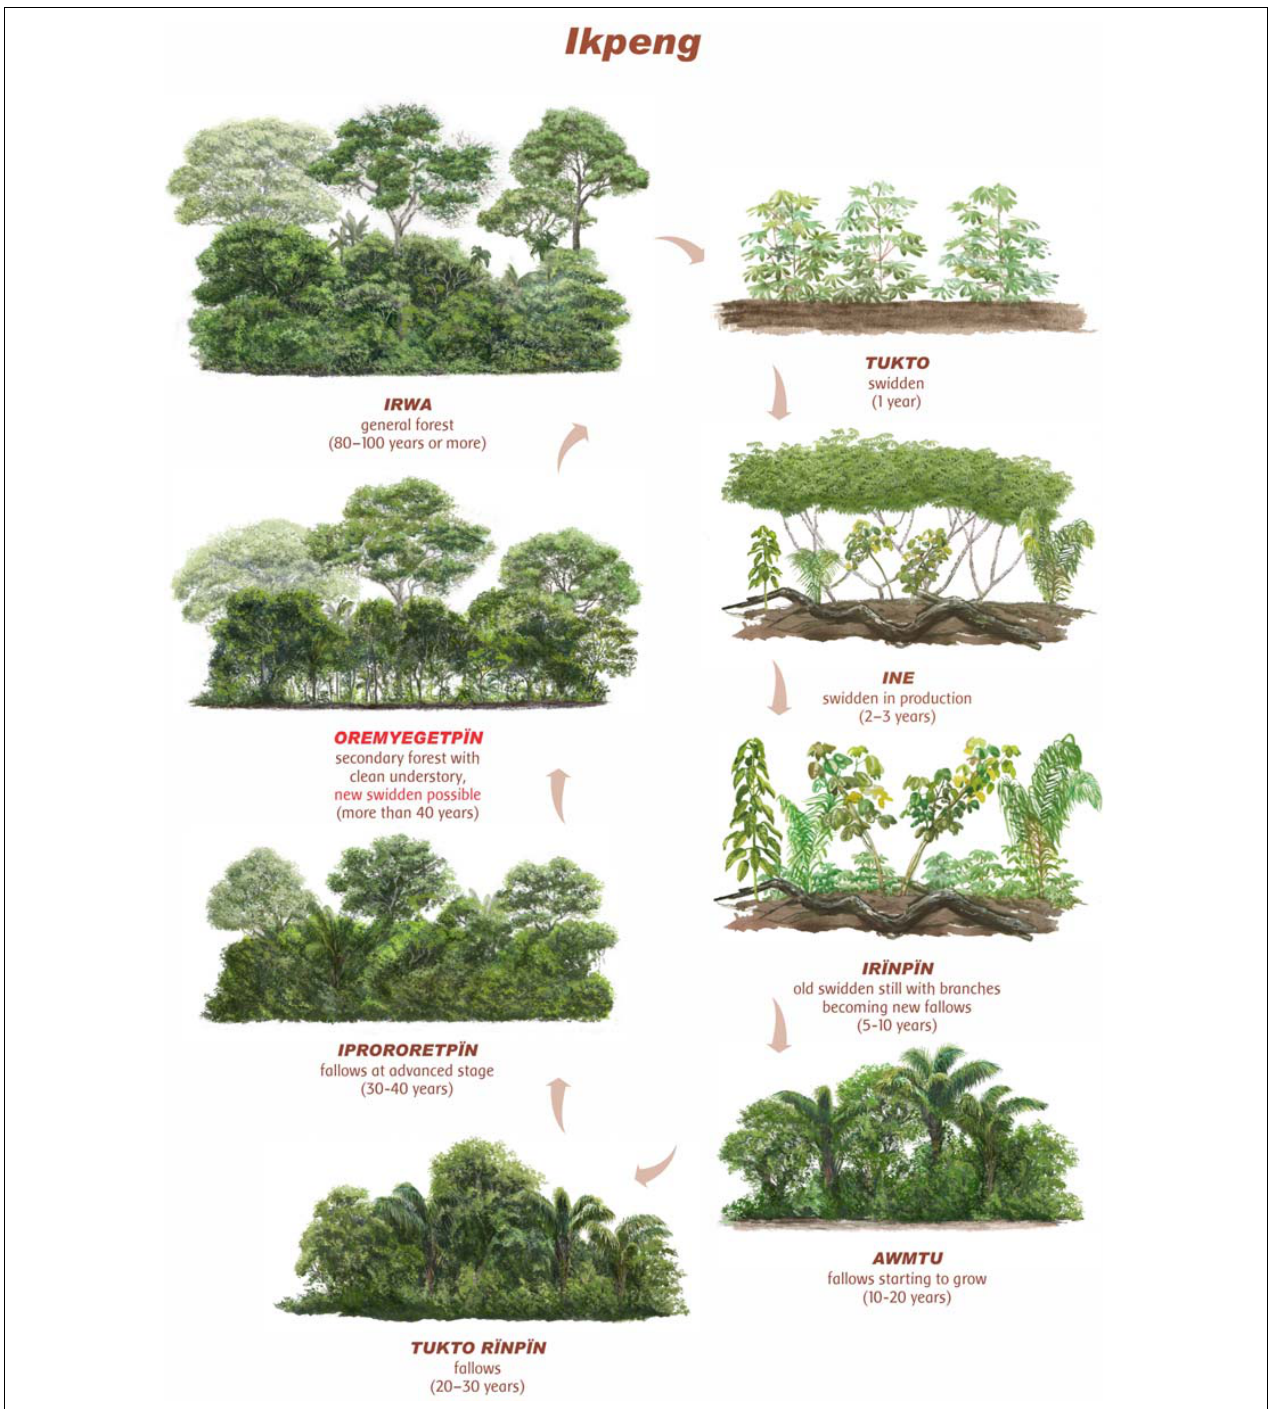
FIGURE 3 | Illustration of Ikpeng cassava ( Manihot esculenta Crantz) shifting cultivation cycle in non-anthropogenic soils (nADE). When the fallow reaches the OREMYEGETPÏN phase (in red), soils and vegetation are considered as recovered and a new cycle may start ( Ilustração de Gustavo Marigo ).